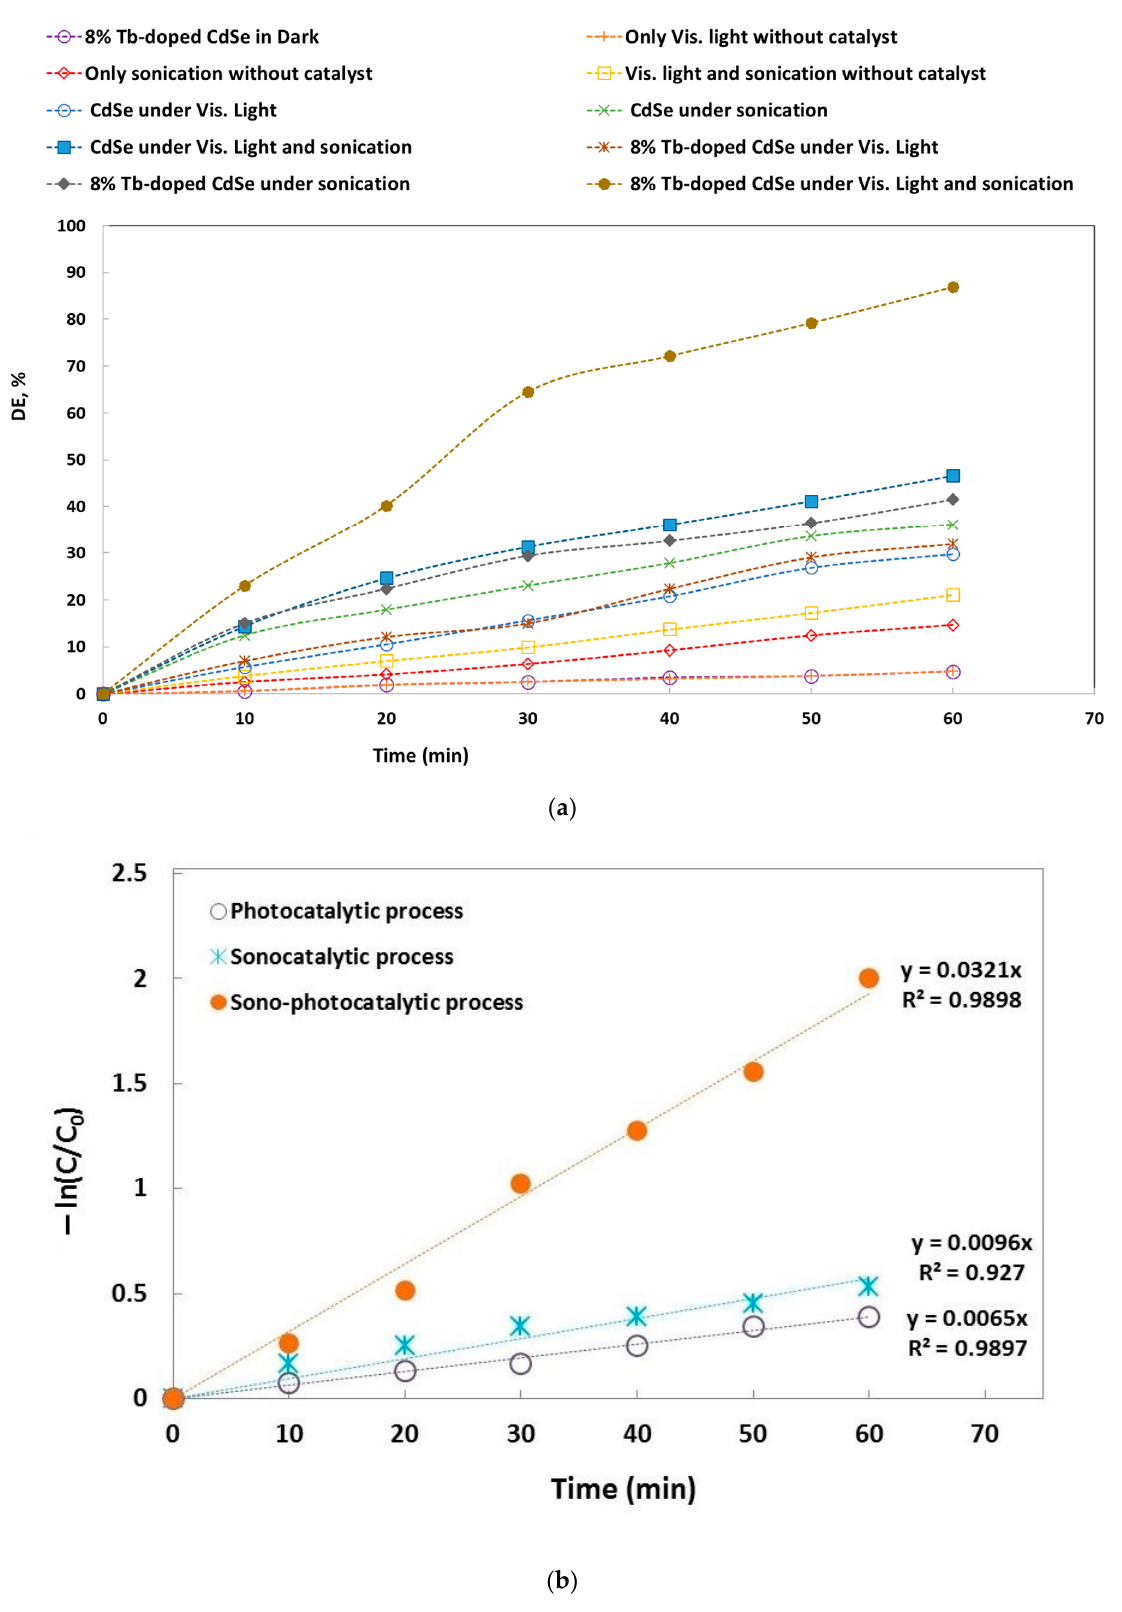
Figure 8. ( a ) Comparing various procedures in decolorizing Reactive black 5, ( b ) First-order kinetic plot for photocatalytic, sonocatalytic and sono-photocatalytic processes. [Dye] = 20 mg/L, [Catalyst] = 1 g/L.